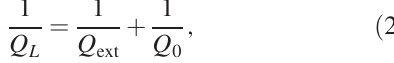
FIG. 5. Schematic drawing of the third harmonic module at FLASH. Four cavities with alternate coupler orientation with respect to the beamline are installed in one